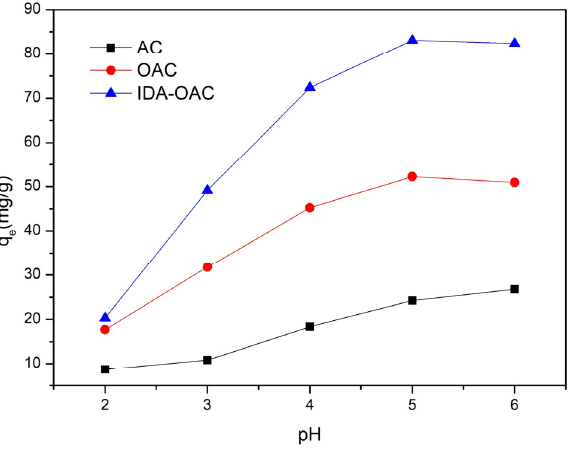
Figure 3. The impact of pH on the copper ion removal of AC, OAC, and IDA-OAC.